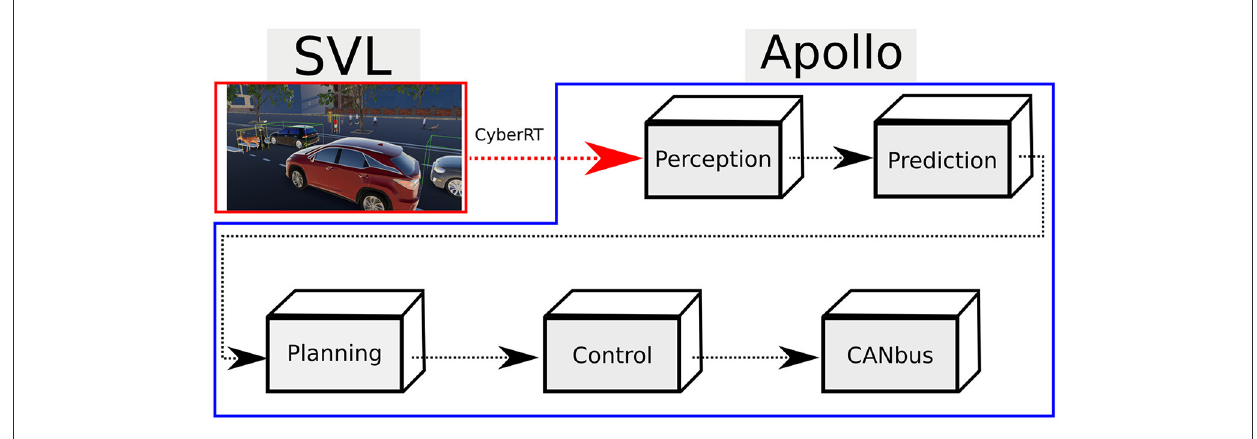
FIGURE1 Apollo software architecture and bridge connection with SVL.